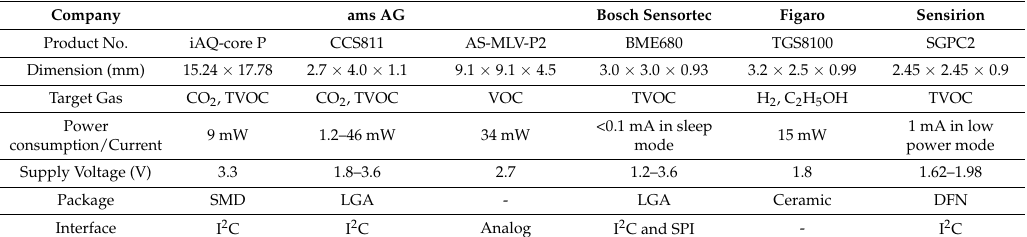
Table 2. Specifications of commercial metal oxide (MOX) gas sensor products. ams AG Bosch Sensortec Figaro